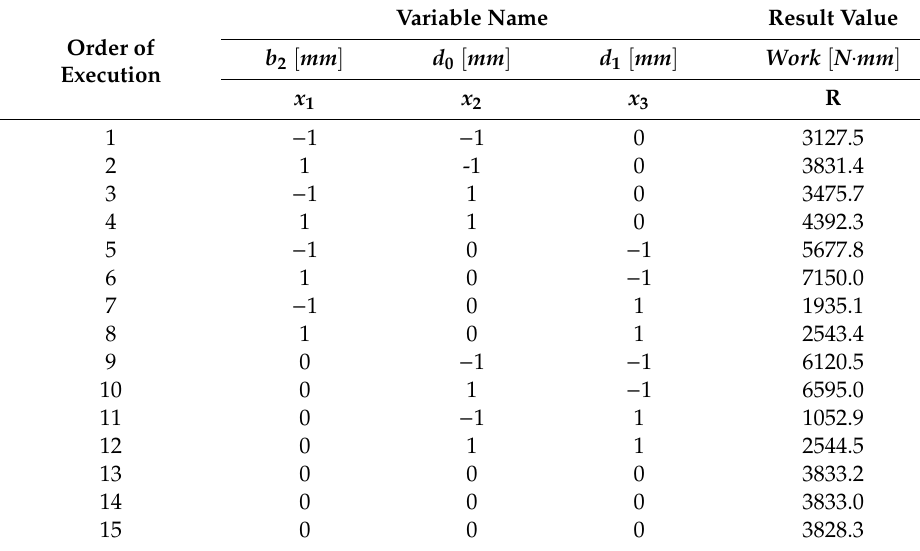
Table 5. Experimental points and results based on the Box–Behnken